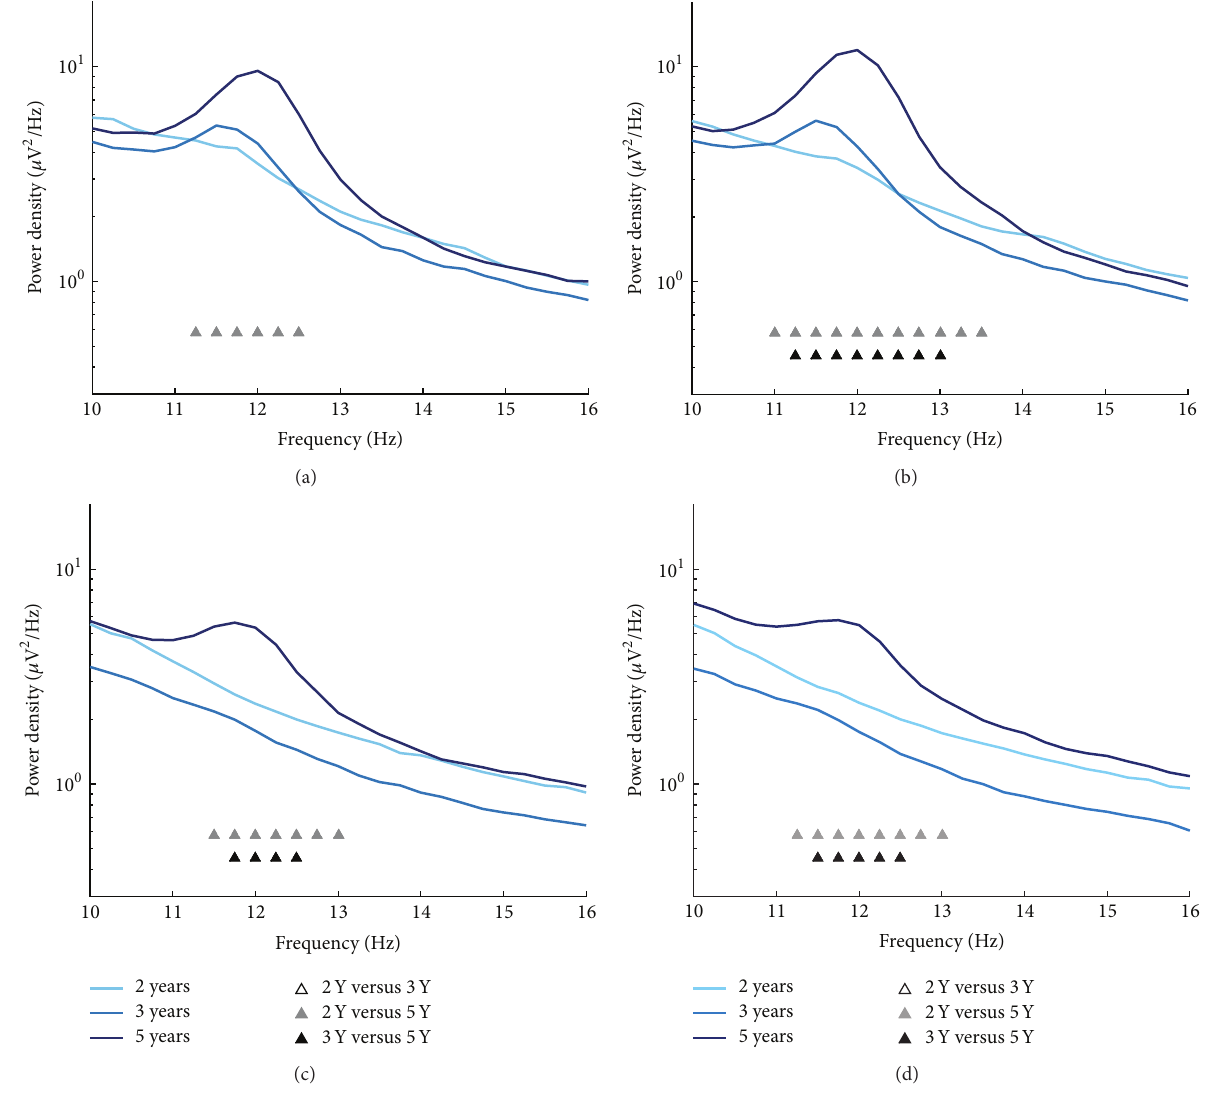
Figure 3: Mean spectral EEG power density spectra for the sigma range (10–16Hz; 0.25 Hz bins) at ages 2, 3, and 5 years at C3A2 (a), C4A1 (b), O1A2 (c), and O2A1 (d). Significant post hoc comparisons between ages are denoted for each frequency